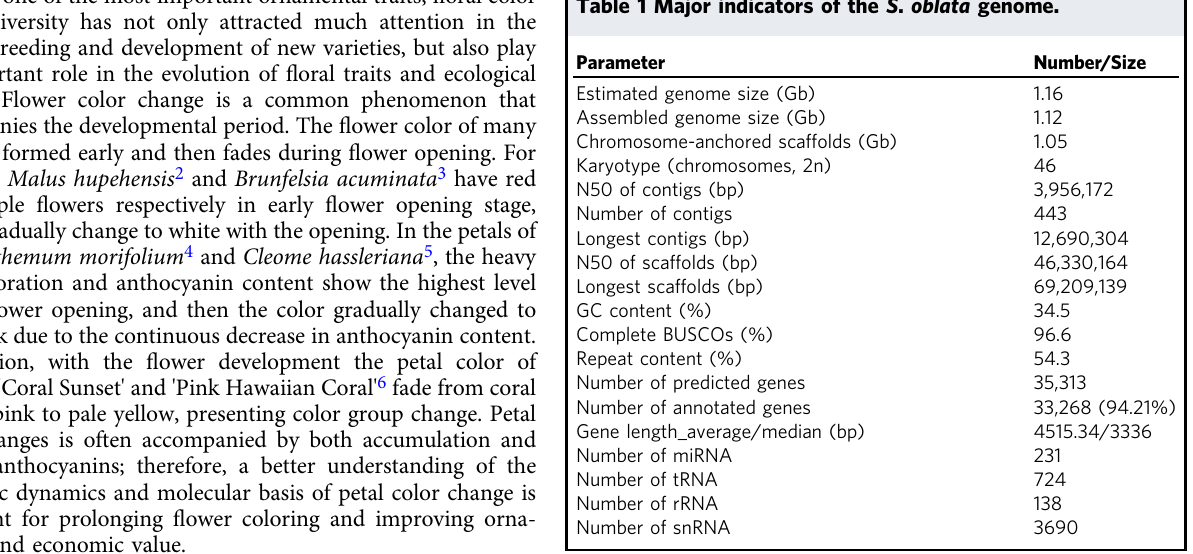
Table 1 Major indicators of the S . oblata